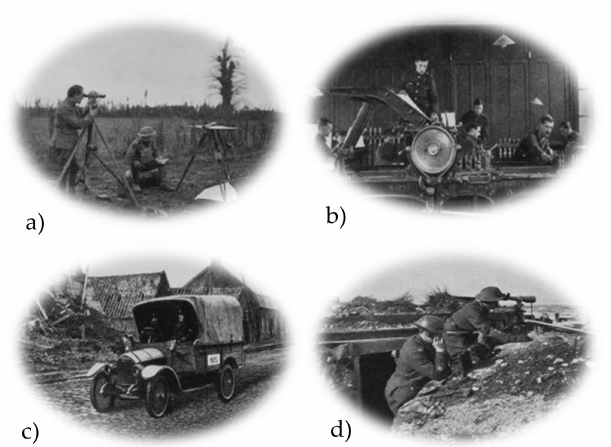
Figure 2. By the 1920s, new-era cadastral mapping was exploiting World War I aerial photography advances to produce higher-accuracy parcel maps (adapted from [36]). ( a ) Triangulation with a Lucas signalizing lamp; ( b ) printing office of a field survey battalion; ( c ) map distribution by car; ( d ) first establishment of flash-spotting post in a trench after an advance.